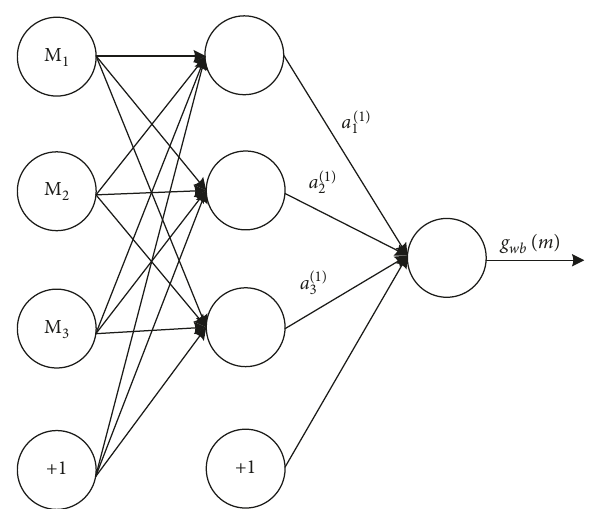
Figure 1: Single hidden layer neural network structure